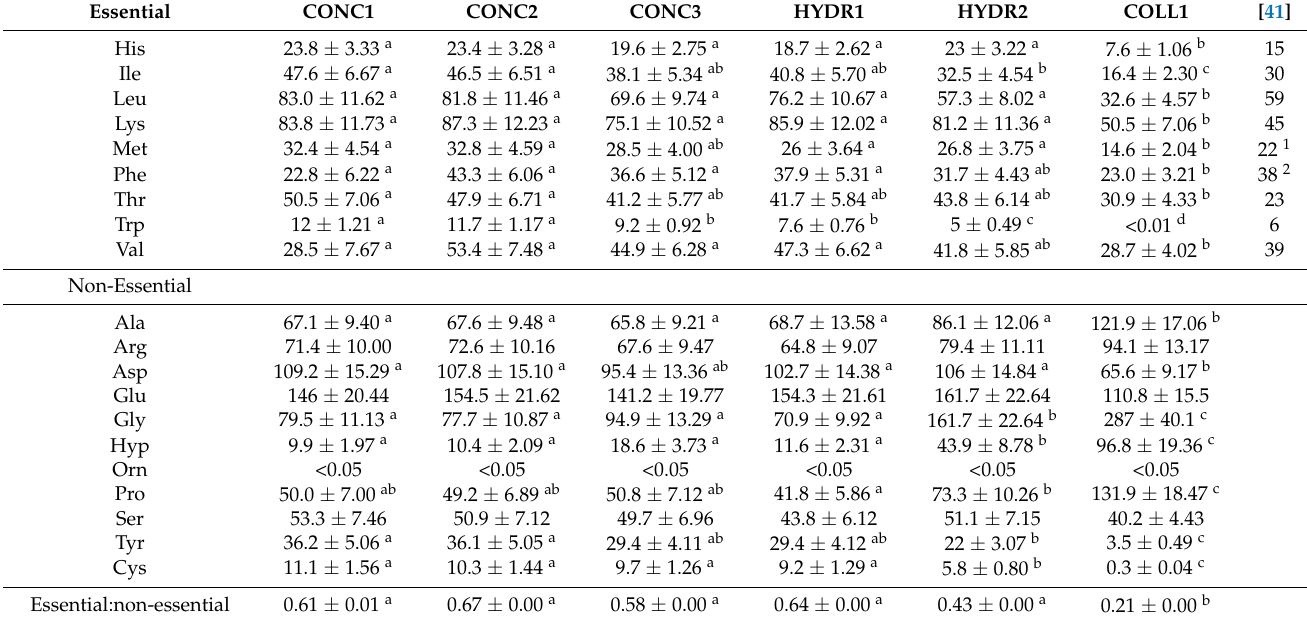
Table 3. Total amino acids (mg/g protein) in commercial fish protein concentrates, hydrolysates, and hydrolyzed collagen with mean and standard deviation of three replicate measurements. The amounts are compared to the daily requirement (mg/kg) [41]. Different letters within the same row indicate a statistically significant difference with ANOVA post hoc pair comparison ( p <